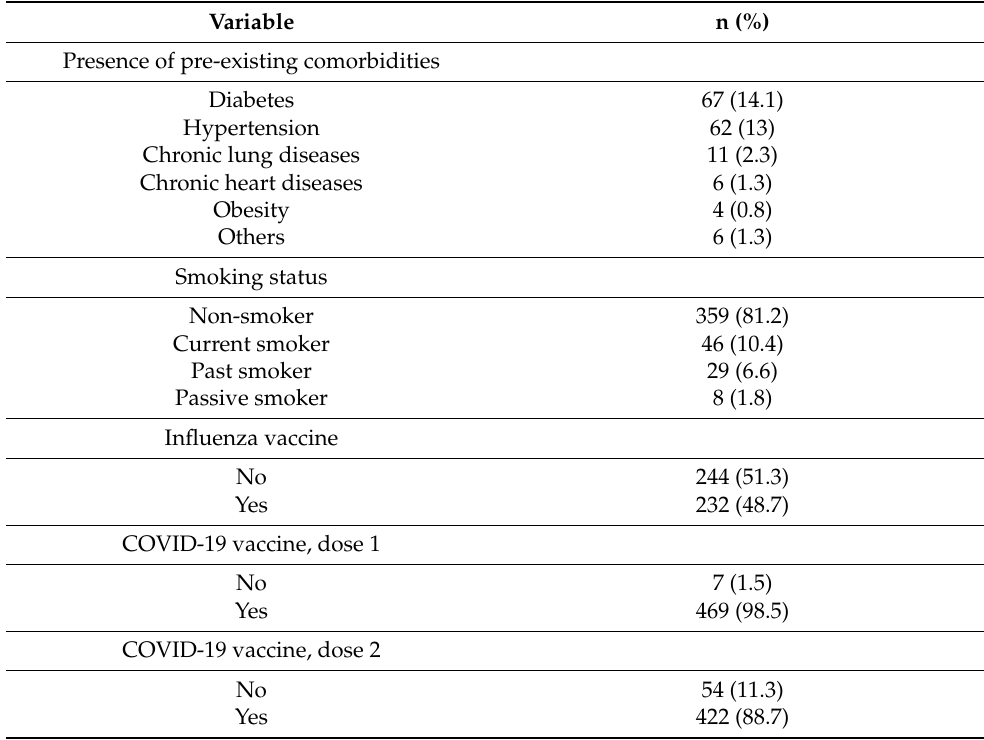
Table 2. Participants’ medical history and vaccination status (n =